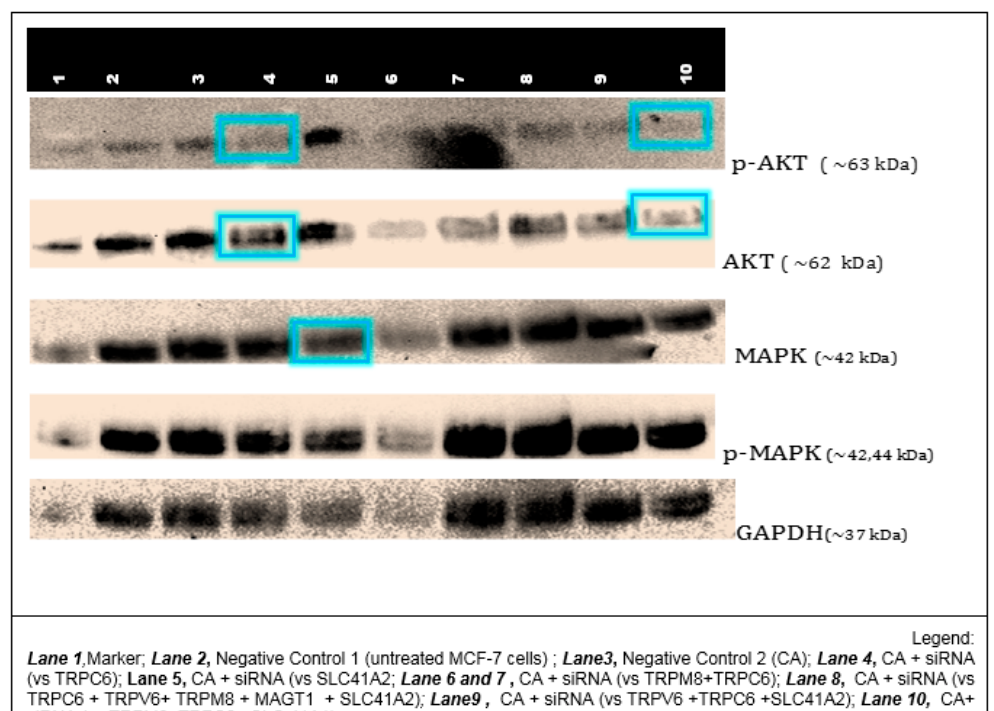
Figure 10. Western blot analysis for 42/44-ERK (total MAPK) and total AKT and their phosphorylated forms following treatments with NP-siRNA against calcium and magnesium channels and transporters.